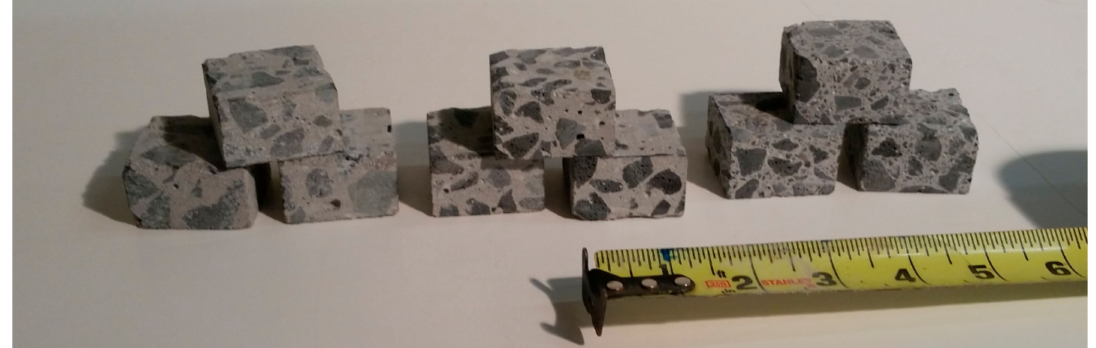
Figure 1. Concrete test specimens utilized for heat capacity and thermal conductivity testing: NWC (left), LWC (center), ALC